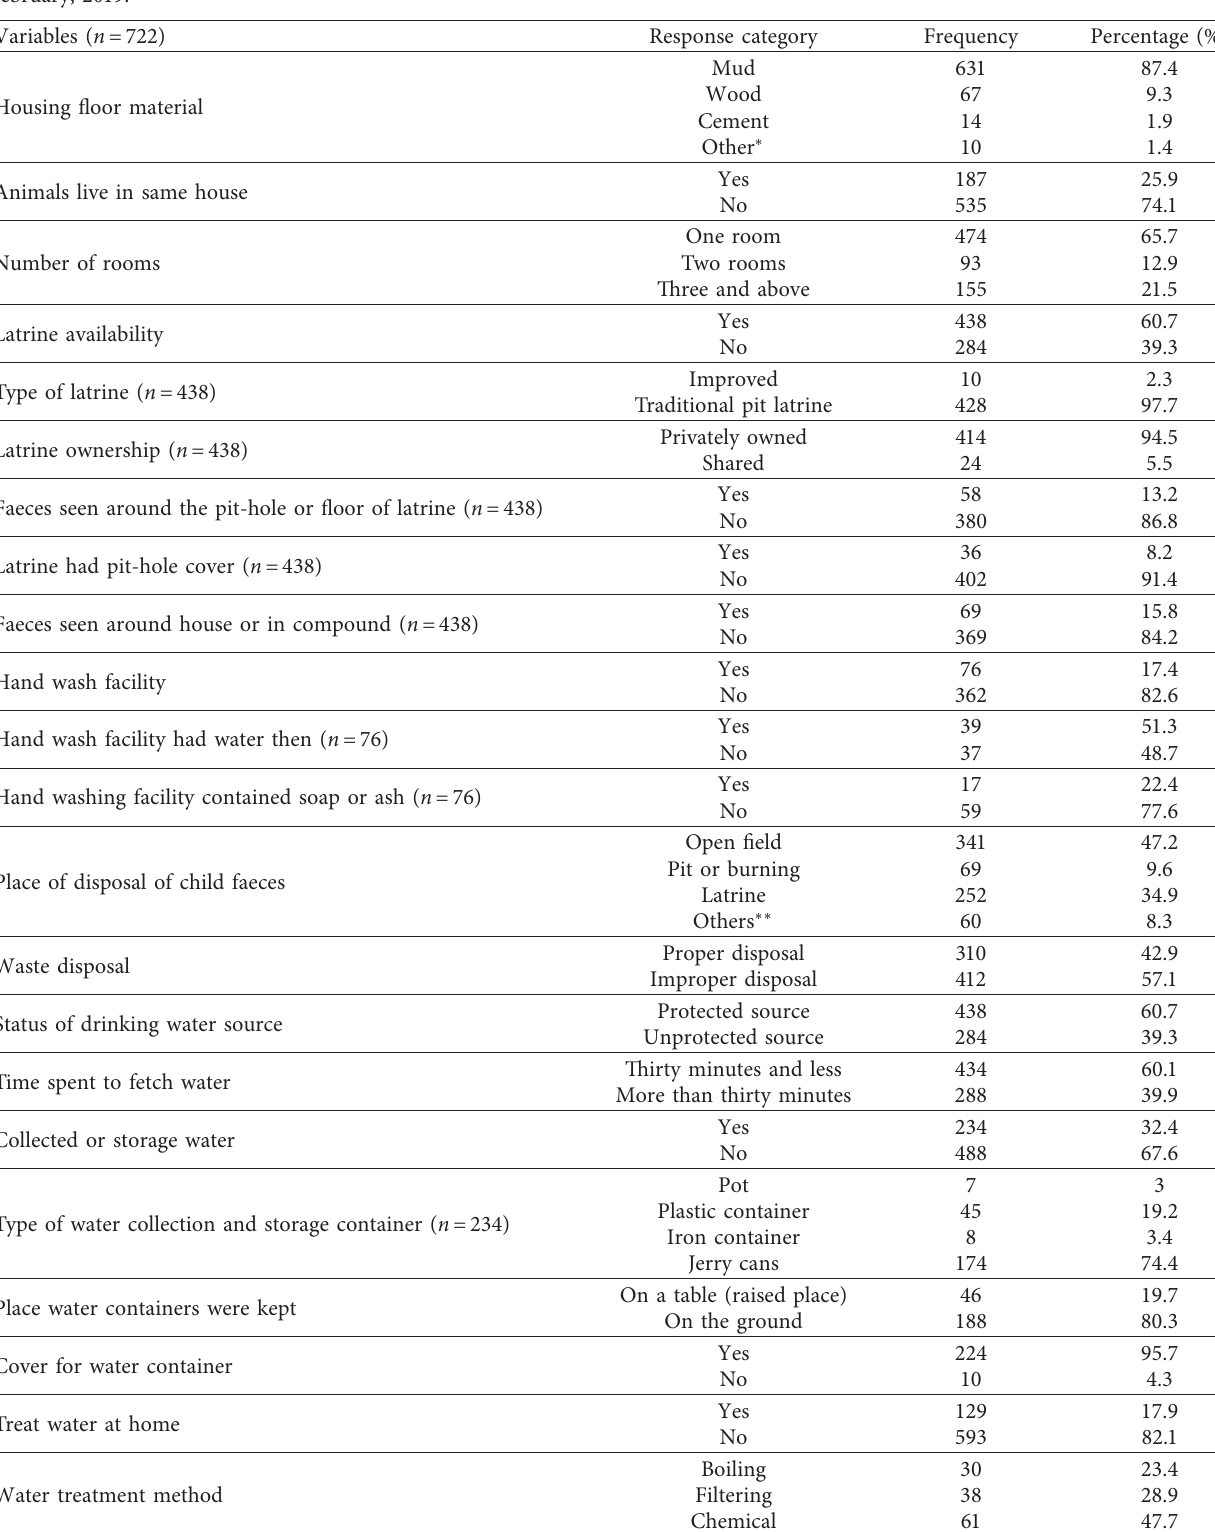
Table 2: Environmental characteristics of the households in Benna Tsemay District, South Omo Zone, Southern Ethiopia, 01 January to 30 February,